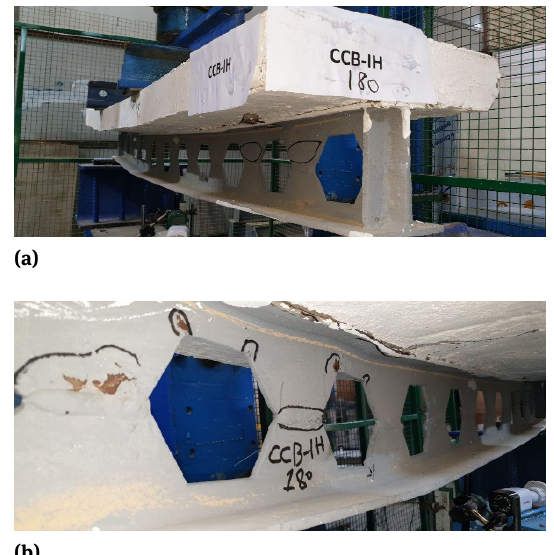
Figure 17: Failure mode of Specimen